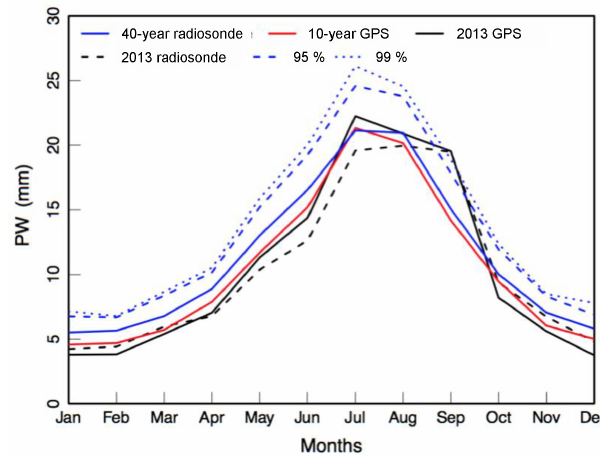
Figure 5. Monthly-averaged GPS PW (solid black line) and ra- diosonde data (dashed black line) for 2013 with the 10-year merged GPS PW dataset (solid red line) and the 40-year averaged ra- diosonde PW dataset (solid blue line). Additionally, there are the 95th (dashed red line) and 99th (dotted red line) percentiles for 10 years of GPS data and the 95th (dashed blue line) and 99th (dot- ted blue line) percentiles for 40 years of radiosonde data.